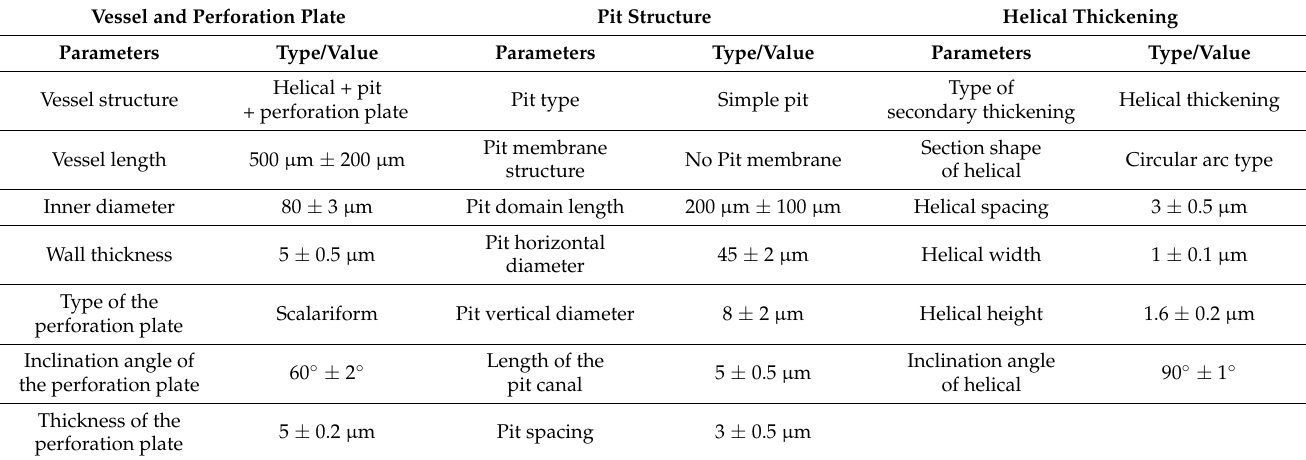
Table 1. Geometry parameters of Magnolia .